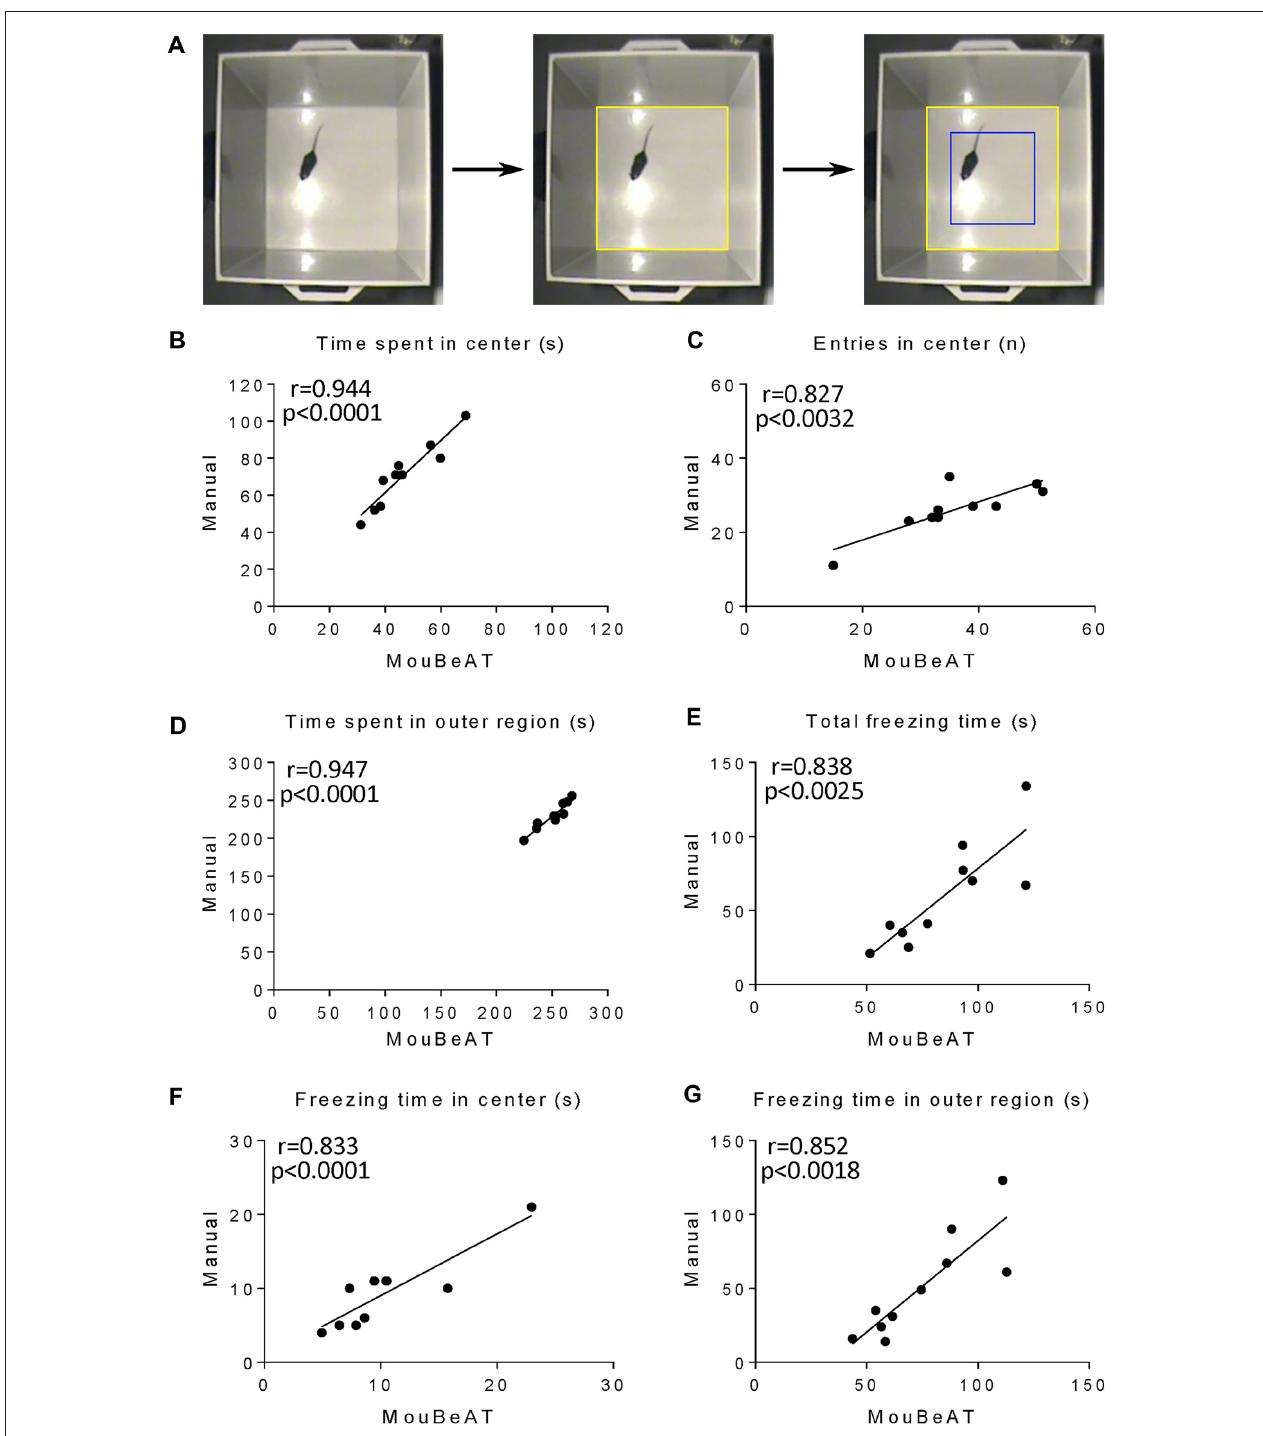
FIGURE 2 | Correlation of the measured variables in the open field (OF) test between MouBeAT and manual assessment. The OF test (A) was performed using 10 C57BL/6J male mice. Yellow ROI defines the base of the cube while blue ROI indicates the center region calculated by the software. Each dot represents time spent in the center (B) , number of entries into the center (C) , time spent in outer region (D) , total freezing time (E) , freezing time in the center (F) and freezing time in the outer region (G) for each mouse. In this and all subsequent Figures Pearson’s correlation coefficients were calculated for all variable except in cases where data followed a non-parametric distribution, in which case the Spearman correlation coefficient was used. Individual p values are displayed in the Figures. For (F) the Spearman correlation coefficient was used.